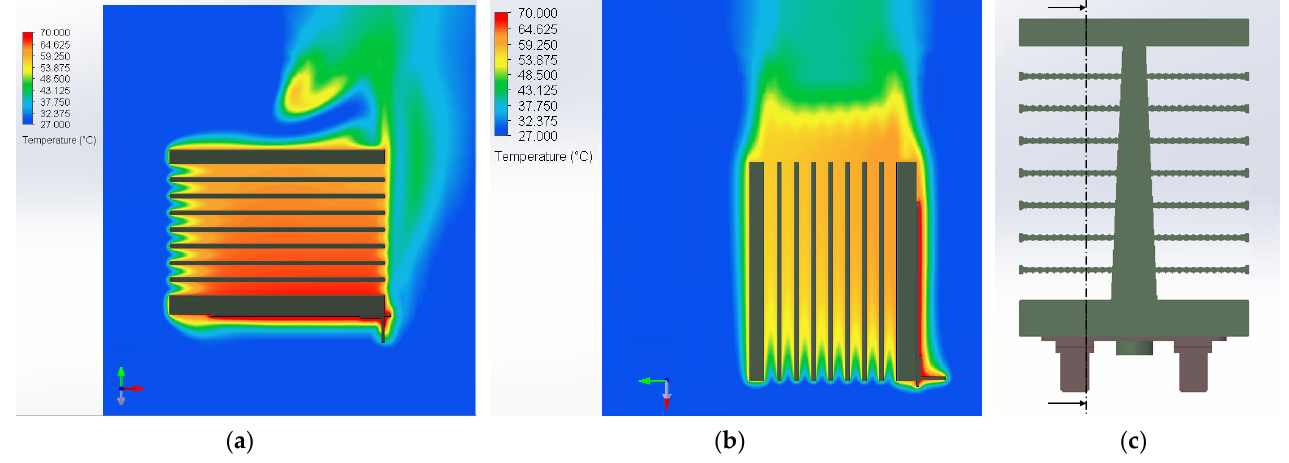
Figure 15. ( a ) Air temperature of Setup 1—section view; ( b ) Air temperature of Setup 2—section view; ( c ) Section plane.